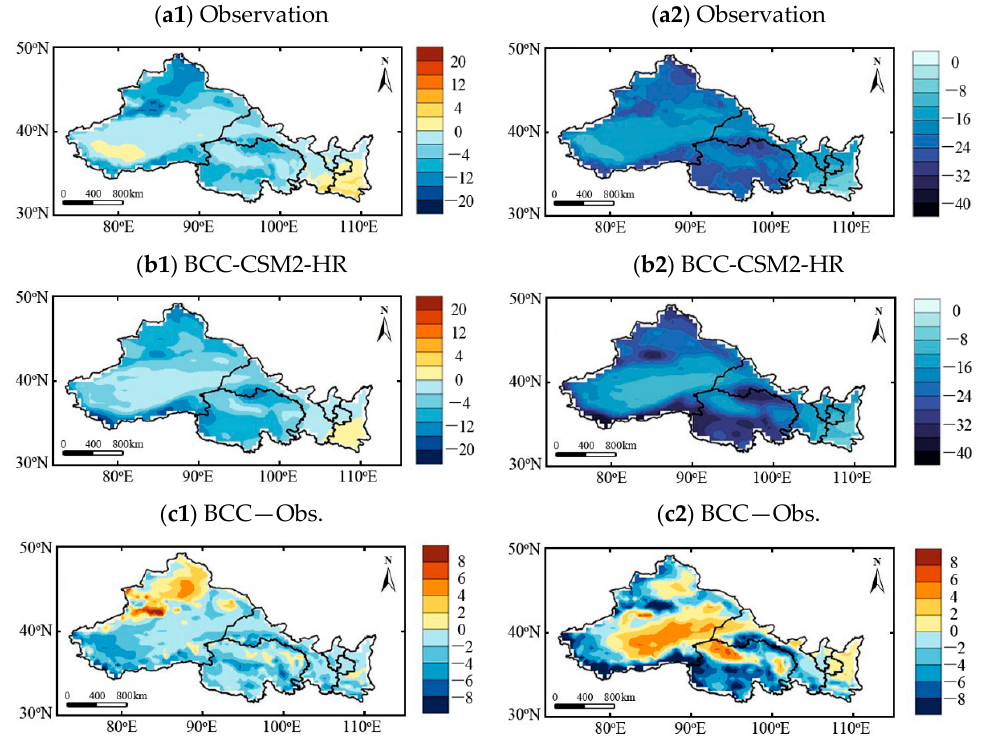
Figure 5. Spatial distribution of TXn ( left ) and TNn ( right ) over Northwest China during 1961–2014: observations, the values simulated by the BCC-CSM2-HR, and the difference between them. Unit: °C .